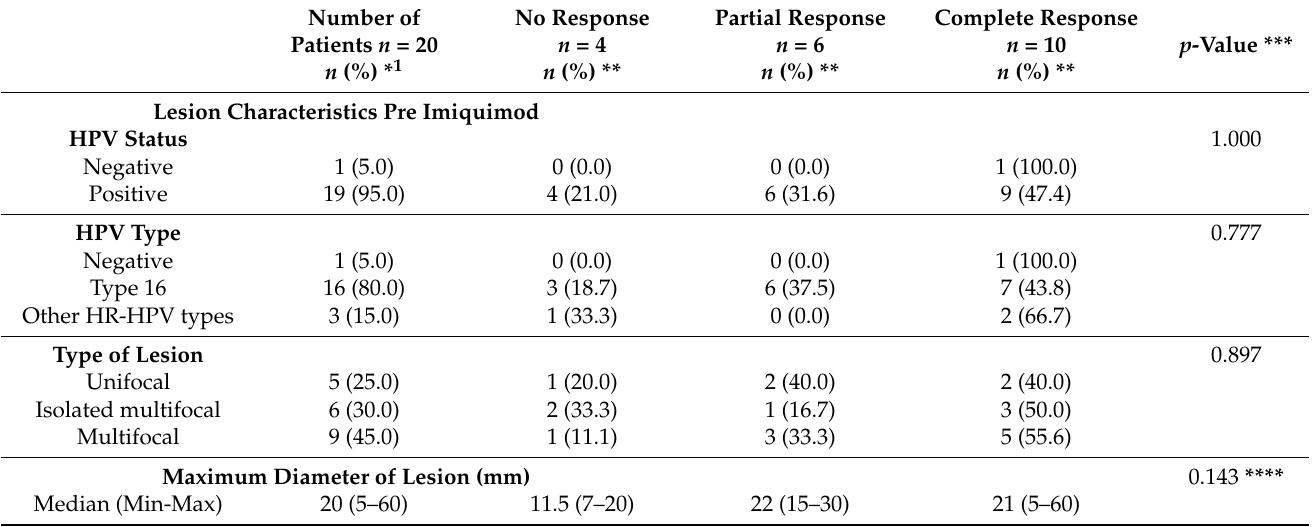
Table 2. Lesion characteristics pre-post imiquimod treatment. Patients treated with imiquimod